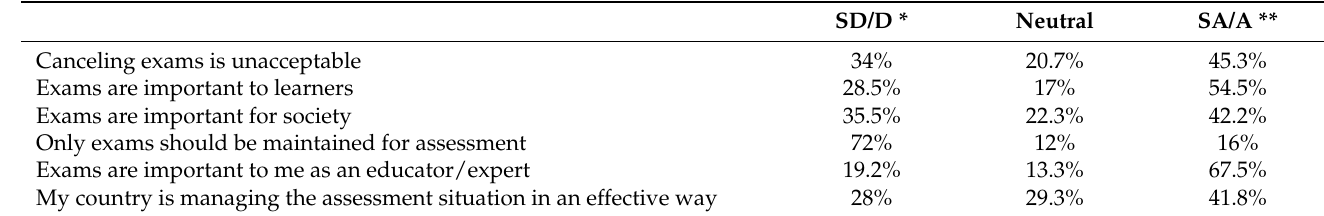
Table 3. Teachers’ perceptions of assessment measures under COVID-19.